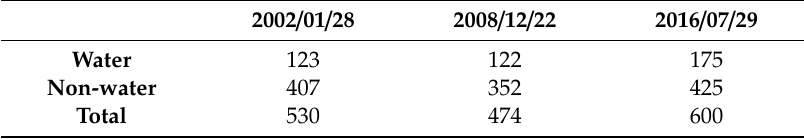
Table 2. Number of validation samples for each class in three di ff erent